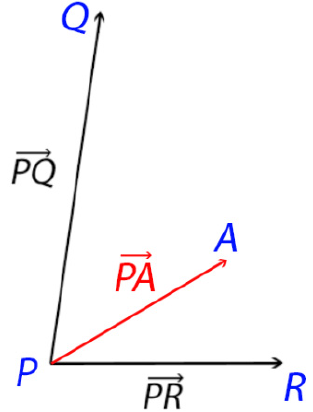
Figure 20. PQ, PA, PR vectors.